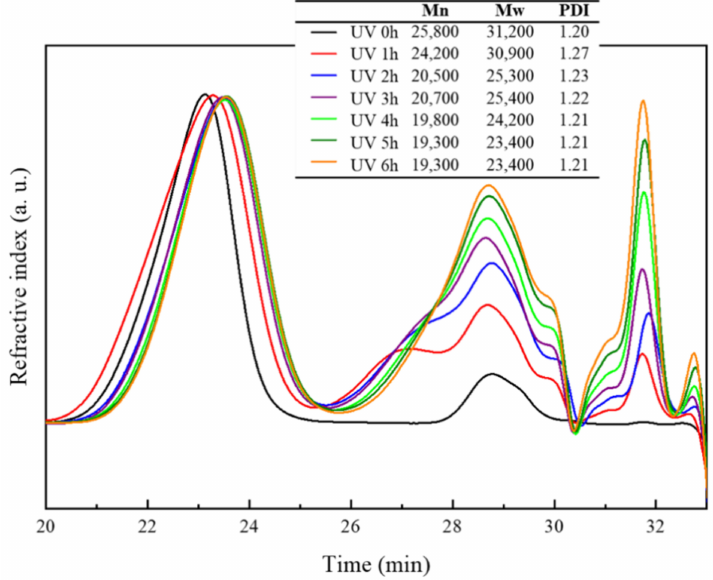
Figure 7. Molecular weight loss of PCL-b-PLA-b-PMVK according to UV irradiation time (entry 2 in Table